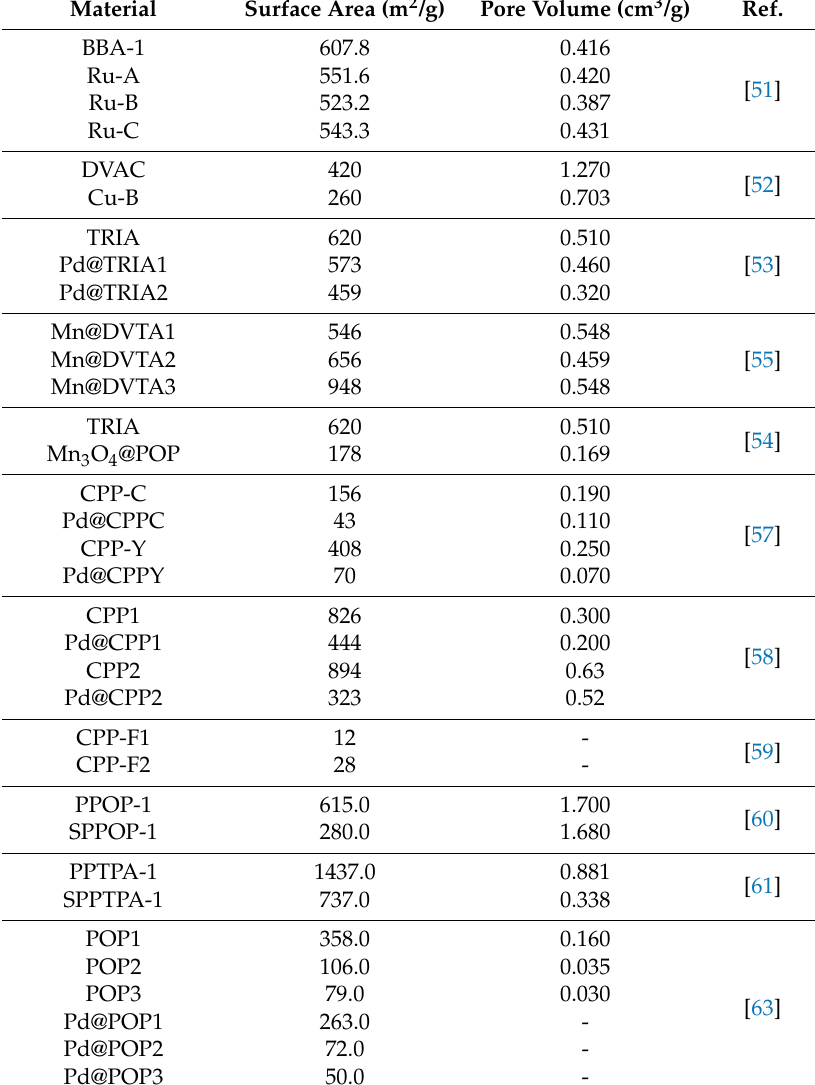
Table 3. BET surface areas and porosities of neat, metal encapsulated, and functionalized